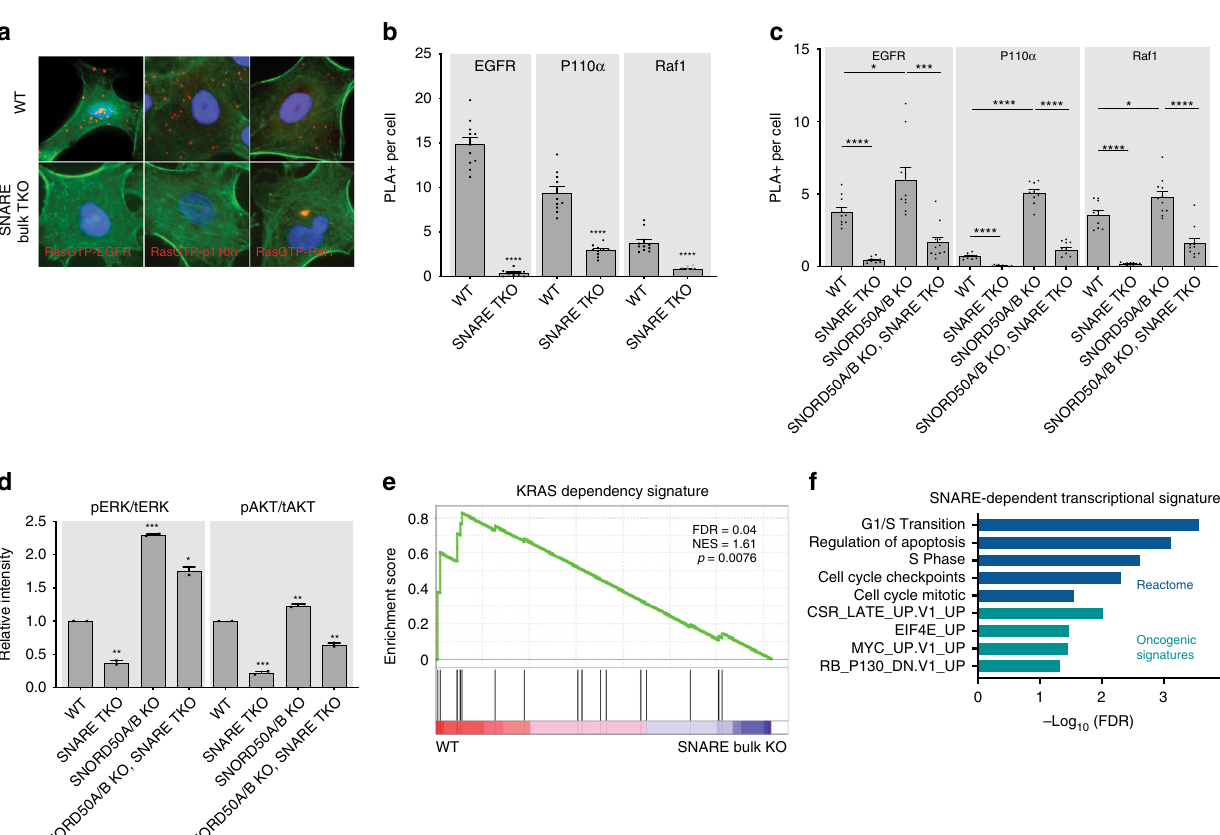
Fig. 5 Downstream KRAS signaling relies on SNARE proteins. a Representative PLA images of Ras-GTP interaction with EGFR, P110 α , and Raf1 in A549. F- actin labeled in green. b Quanti fi cation of PLA signal in a . c Proximity of KRAS with membrane bound receptors and signaling effector proteins measured by PLA in H23 cells. d ERK1/2 and AKT activation in H23 cells; quantitated replicate western blots of phosphorylated pERK and pAKT over total levels of these kinases (tERK, tAkt) are shown. e GSEA plot of KRAS-dependent transcripts against RNA-sequencing datasets of SNARE wild-type and KO cells in H23. f Gene sets lost upon SNARE TKO in H23, A549, and CHL1 from RNA sequencing. Error bars are